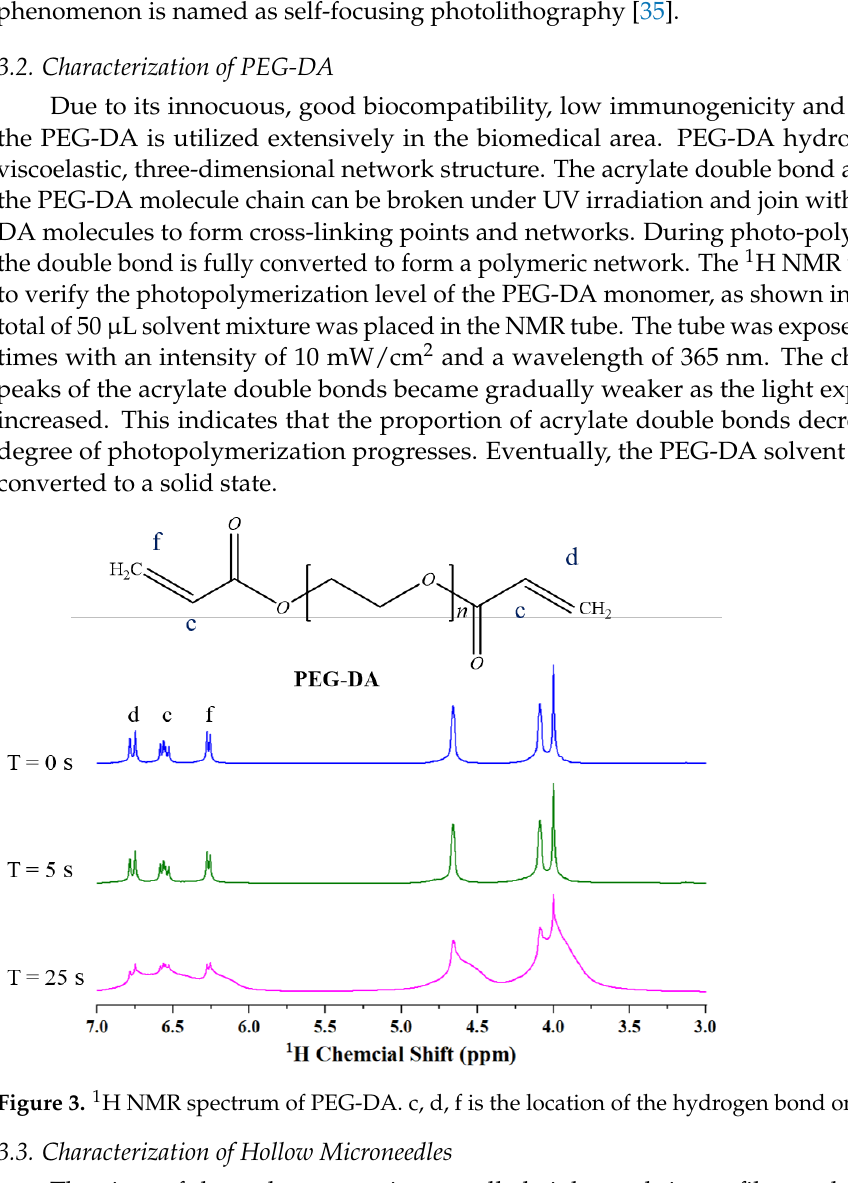
Figure 2. Principle of lithography on the foundation of variable refraction index PEG-DA. UV re- fracted at the interfacial region of the uncured and photocured PEG-DA. ( a – d ) The formation pro- cess of hollow microneedles.